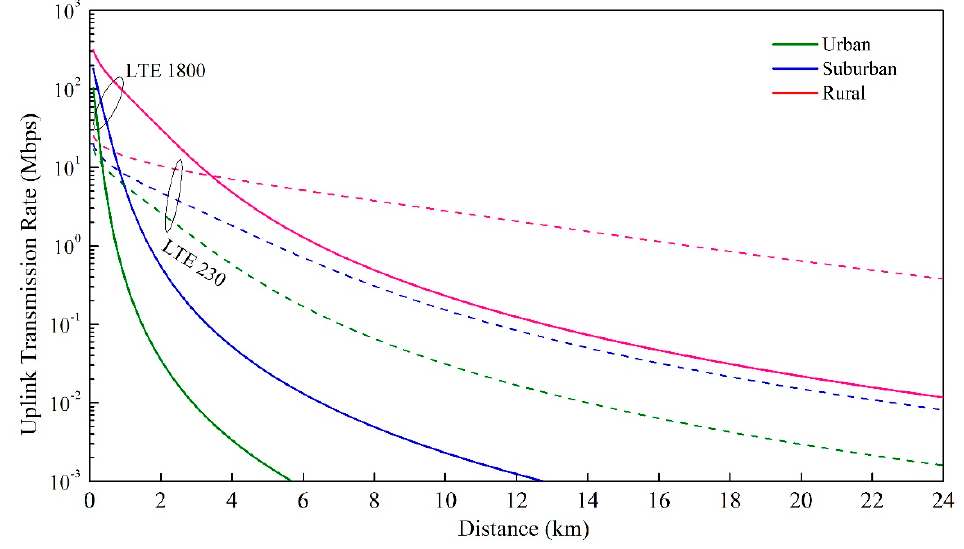
Figure 13. Uplink transmission data rate comparisons between LTE 1800 and LTE 230 in different environments.